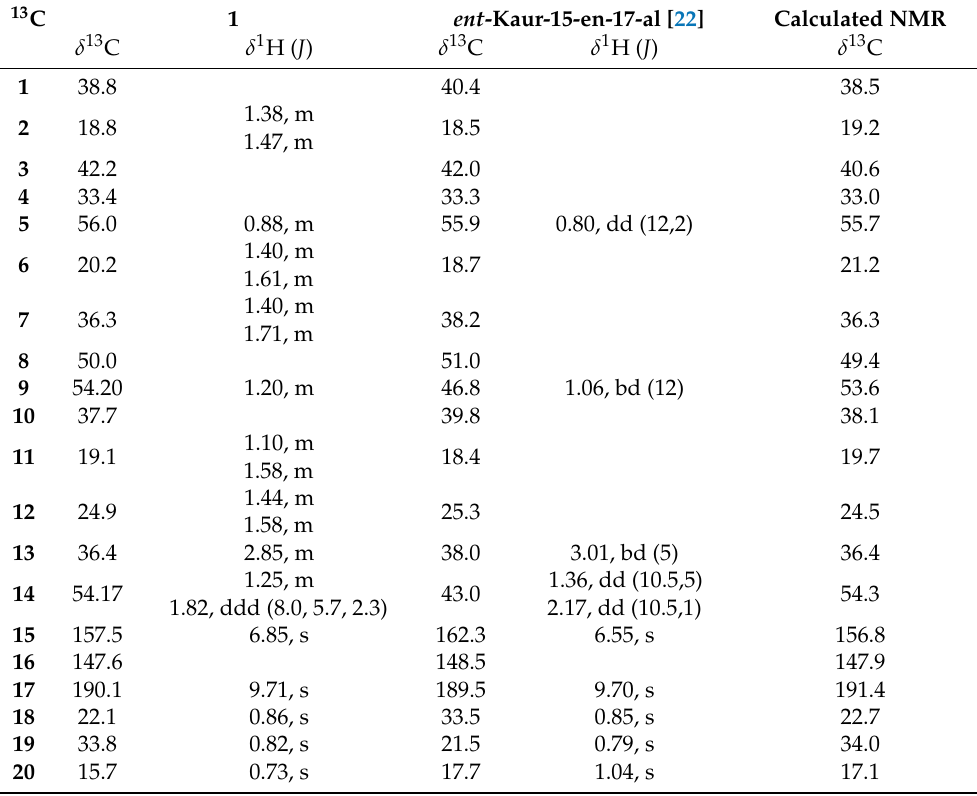
Table 1. 13 C and 1 H NMR spectral data of 1 and its diastereomer, ent -kaur-15-en-17-al (CDCl 3 solution, δ values in ppm, J values in